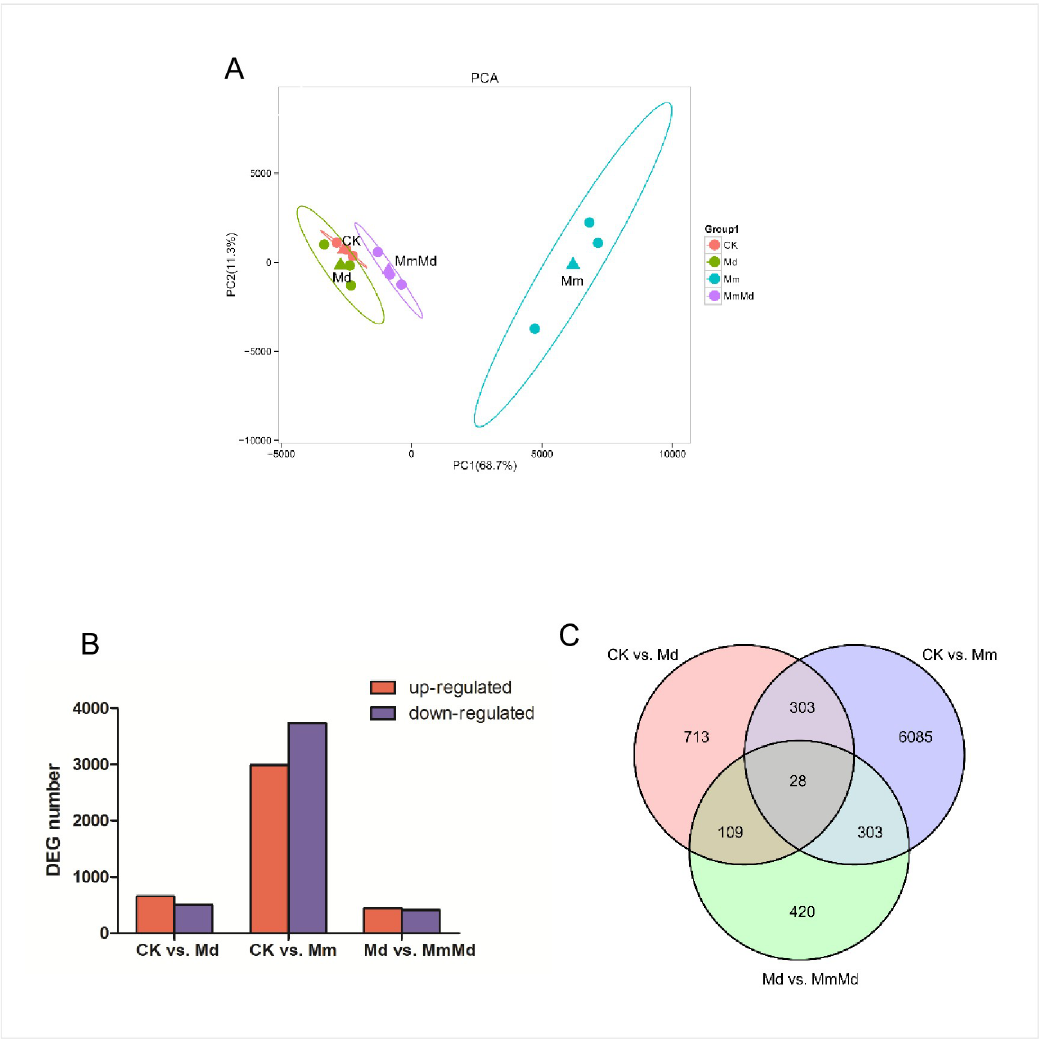
Fig 3. PCA plot and differentially expressed genes (DEGs). PCA plot based on the FPKM of all expressed genes (A). Numbers of up- and down-regulated genes in CK vs. Md, CK vs. Mm, and Md vs. MmMd (B). Venn diagram of differentially expressed genes (DEGs)